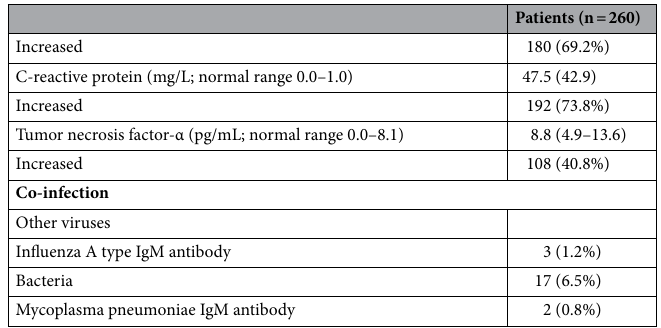
Table 2. Laboratory findings of patients infected with COVID-2019 on admission.